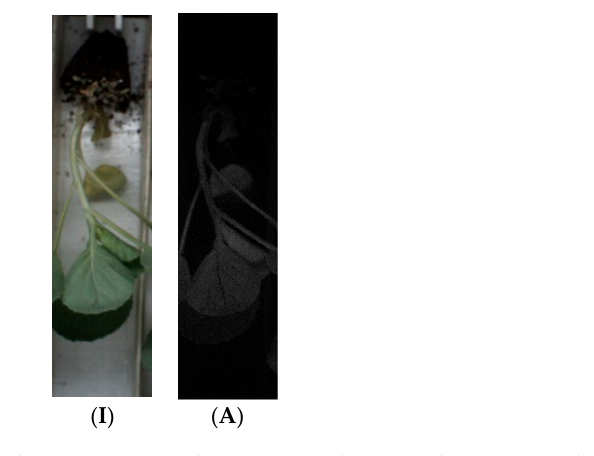
Figure 4. Experimental pictures in the excess green color space. ( І ) The original image. ( A ) The image in the excess green color space.